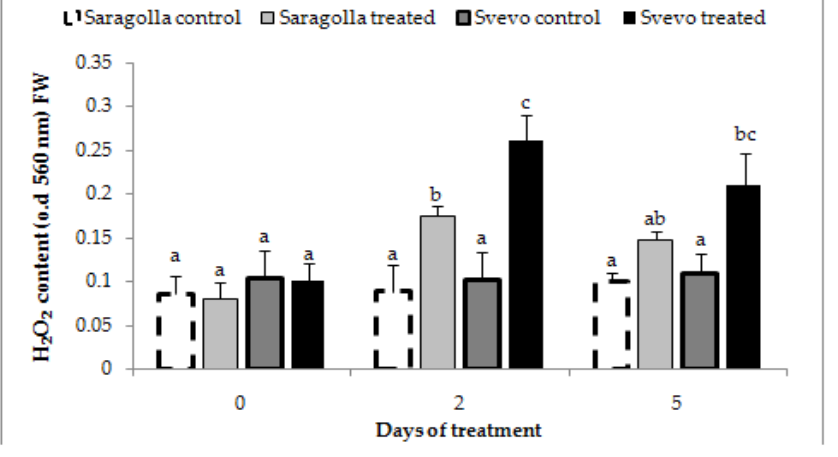
Figure 5. H 2 O 2 production in Saragolla and Svevo roots subjected to osmotic stress. Seven days-old Saragolla and Svevo seedlings were subjected to osmotic stress treatment for 5 days, by means of 18% PEG-6000 administration and after 2 and 5 days the H 2 O 2 concentration in roots of control and stressed samples was measured as reported in Section 4.5, and values compared to those of control, unstressed seedlings. Results from three independent experiments are reported; values are expressed as the mean ± SD. Statistical significance was attributed by one-way ANOVA test. Bars labeled with dissimilar letters are significantly different ( p < 0.05).